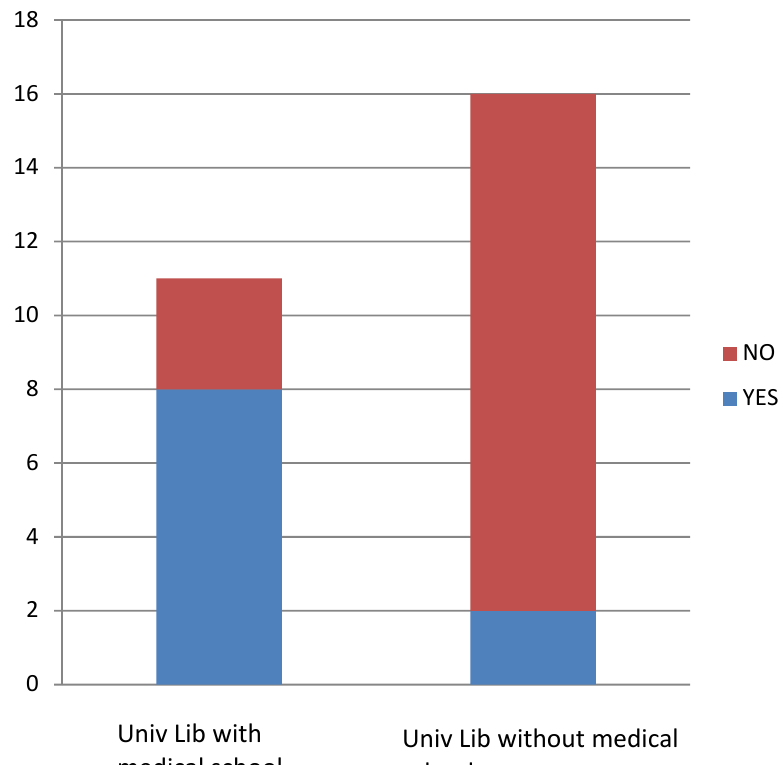
Figure 9. Membership in an OA advocacy